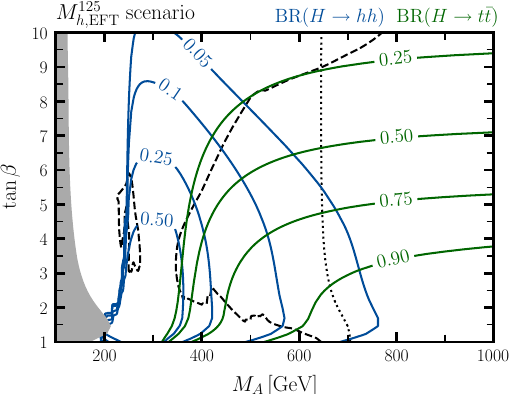
Fig. 3 Left : Branching ratios of the heavy CP -even Higgs boson H into a pair of the light CP -even Higgs bosons h ( blue ) and into a pair of top quarks ( green ) as a function of M A and tan β in the M 125 scenario. Right : Branching ratios of the CP -odd Higgs boson A into a